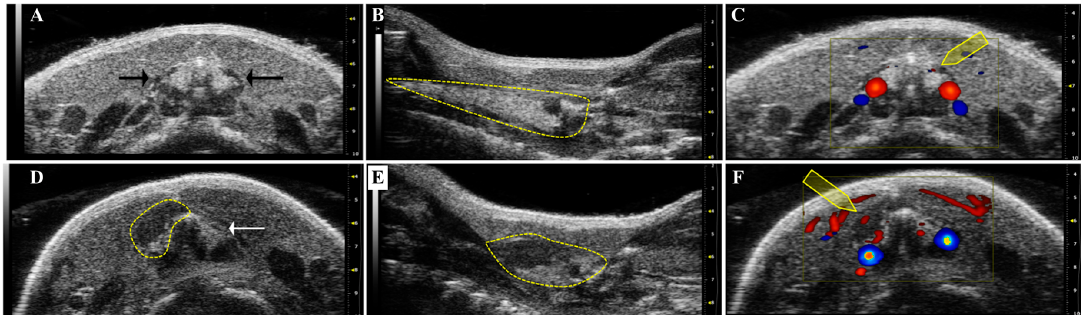
Figure 2. HFUS of the neck region of normal ( A – C ) and of orthotopic ATC bearing mouse ( D – F ). In ( A ): trans-axial brightness (B-)mode scan of the neck region at the level of the first tracheal rings; black arrows point to the normal thyroid lobes. In ( B ): longitudinal B-mode scan paramedian to the trachea; the yellow dotted line identifies a normal thyroid lobe. In ( C ): trans-axial color-Doppler scan of ( A ); the yellow arrow indicates the low blood flow of the normal thyroid. In red, blood flow towards the ultrasound beam, in blue, blood flow shifting away from it. In ( D ): trans-axial B-mode scan of the neck region at the level of the first tracheal rings; white arrow points to the normal thyroid lobe and the yellow dotted line identifies the orthotopic ATC two weeks after injection. In ( E ): longitudinal B-mode scan paramedian to the trachea; the yellow dotted line identifies the orthotopic ATC two weeks after injection. In ( F ): trans-axial color-Doppler scan of ( D ); the yellow arrow indicates the high blood flow of the orthotopic ATC two weeks after injection. In red, blood flow towards the ultrasound beam, in blue, blood flow shifting away from it.